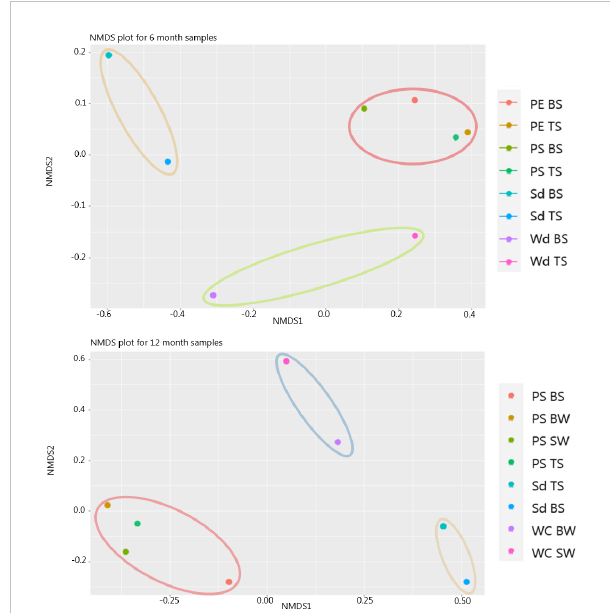
FIGURE 6 Non-metric dimensionally scaled ( NMDS) plot using the Bray-Curtis dissimilarity distance matrix for 6 month and 12 month samples analyzed for 16s rRNA, comparing microbial populations by their abundance and similarity to one another. Acronyms: Surface water (SW), bottom water (BW), oxic top sediment (TS), anoxic bottom sediment (BS), wood (Wd), water column (WC), sediment (Sd) and PE and PS. The 6 month NMDS plot had a stress value of 0.01 in 2 dimensions, and the 12 month NMDS plot had a stress value of 0.06 in 2 dimensions indicating that both plots are a good fi t. The ellipses indicate how the samples group